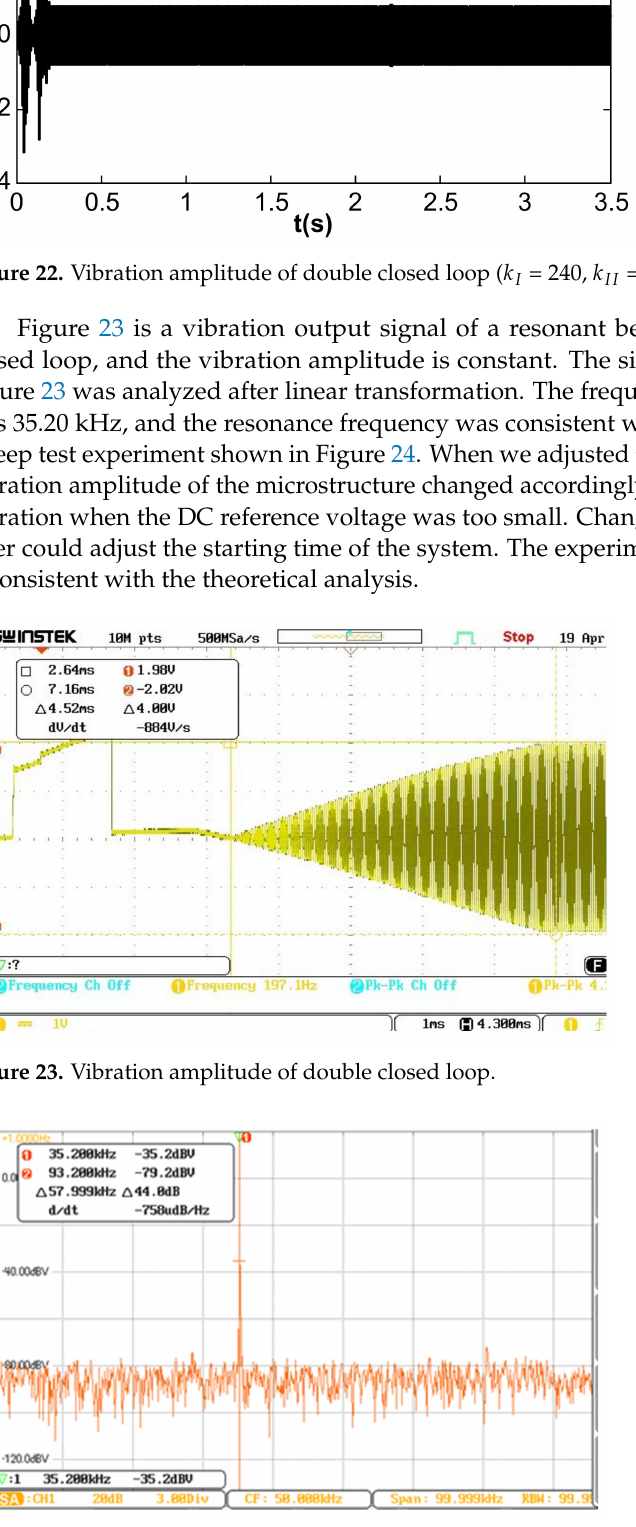
Figure 24. Spectrum of the vibration amplitude